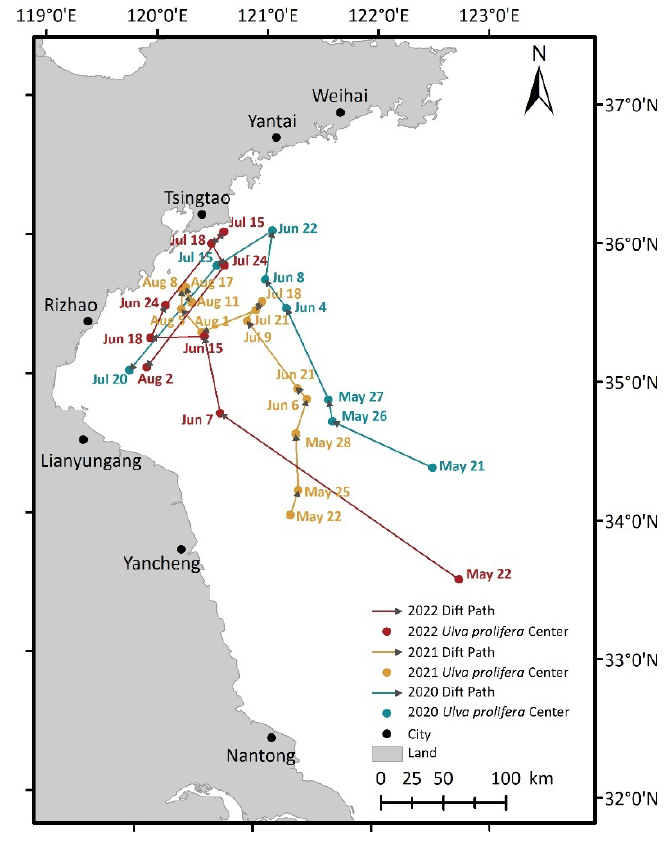
Figure 10. The drift path of U. prolifera in 2021.